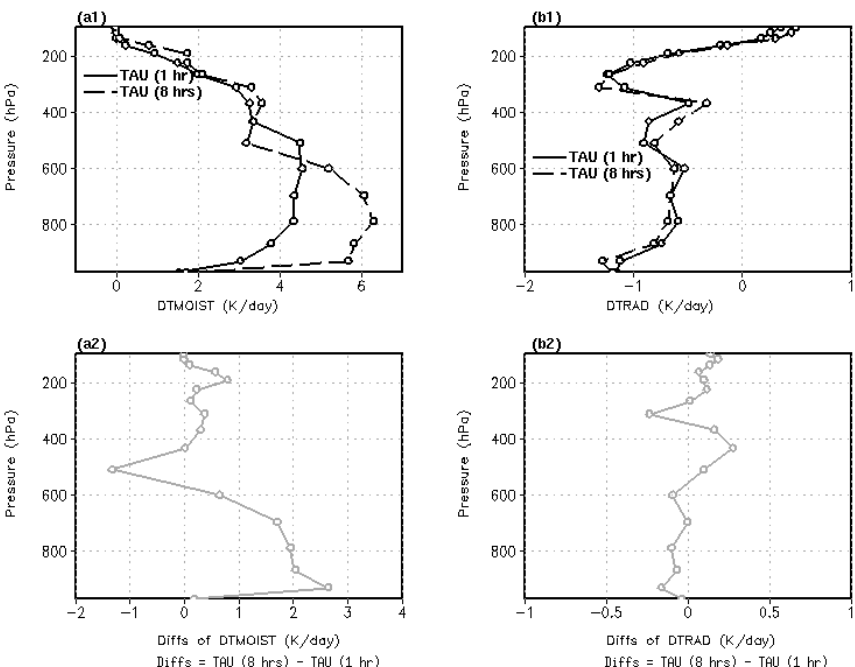
Fig. 9. Top panel shows the vertical structure of the time mean area averaged quantities over 0 ◦ E to 360 ◦ E and 7 ◦ S to 7 ◦ N with TAU (1h) and TAU (8h). (a1) Temperature tendency due to moist processes, (b1) temperature tendency due to radiative processes. Bottom panel shows the differences between TAU (8h) and TAU (1h).